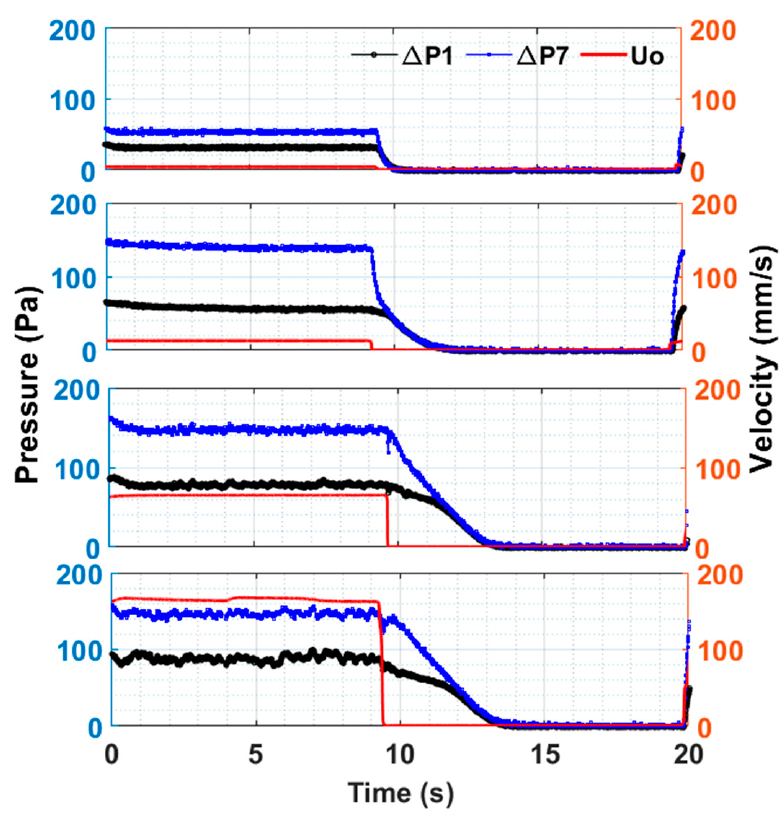
Figure 10. Global ( ∆ P 7 and local (upper region, ∆ P 1 ) bed dynamics in pulsed fluidized bed for 4 mm / s, 12 mm / s, 65 mm / s, 165 mm / s during fluidization